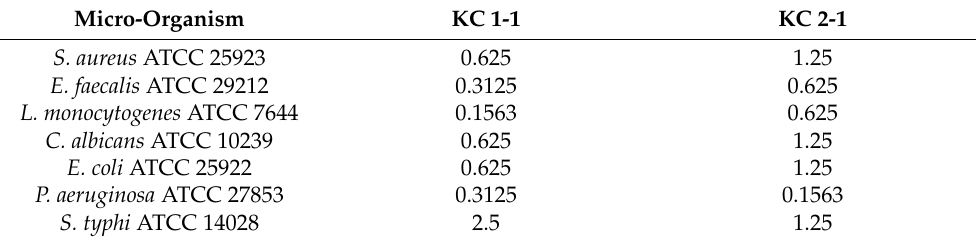
Table 2. Antimicrobial activity, minimal inhibitory concentration (MIC;